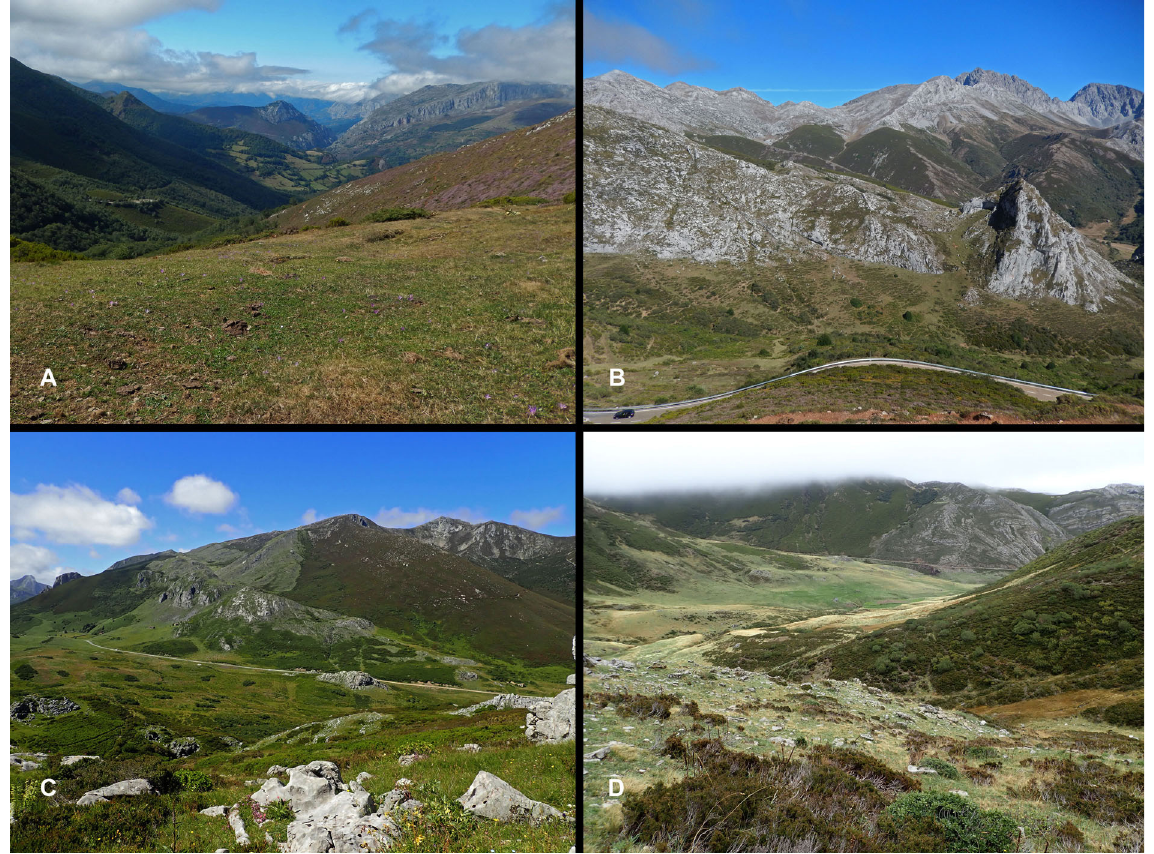
Fig. 11. Typical landscape in the Cantabrian Mountains where Pseudochelidura cantabrica Cuesta- Segura, Jurado-Angulo & García-París sp. nov. is located. A . Puerto de Ventana (zone 1 in Table 5). B . Puerto de Ventana (zone 3 in Table 5). C . Puerto de Vegarada (zone 5 in Table 5). D . Puerto de La Farrapona (type locality; zone 8 in Table 5). Photographs by